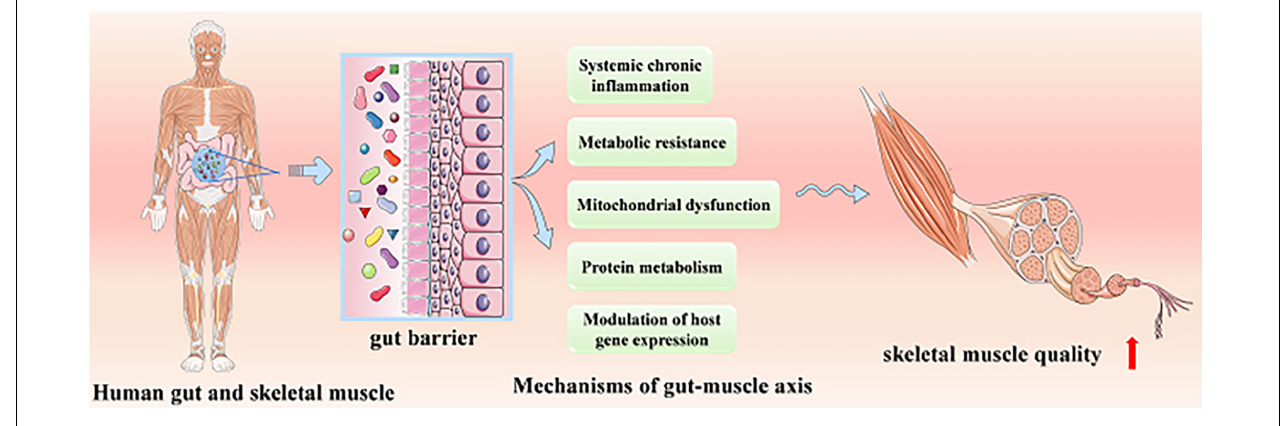
FIGURE 1 | The possible mechanisms of the skeletal muscular improving quality via gut–muscle axis.